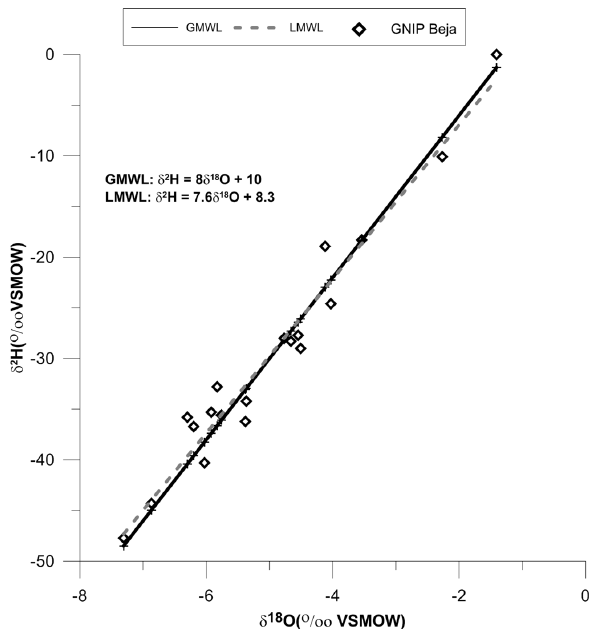
Fig. 4. Local evaporation line (LEL) of streamflow and shallow groundwater for the wet (April) and dry (September)